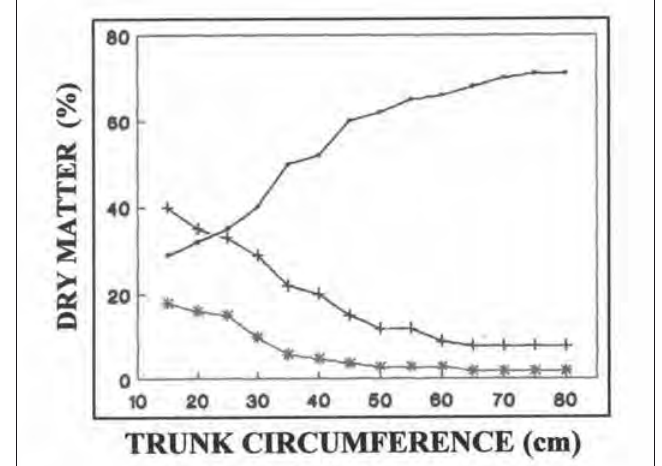
Fig. 19 - Dry matter partition among fruits (points), tree crown (crosses) and root system (asterisks). At increasing tree age represented by the trunk circumference less and less dry matter is allocated in the permanent structure of the tree (redrawn from Chalmers and Van den Ende, 1975).